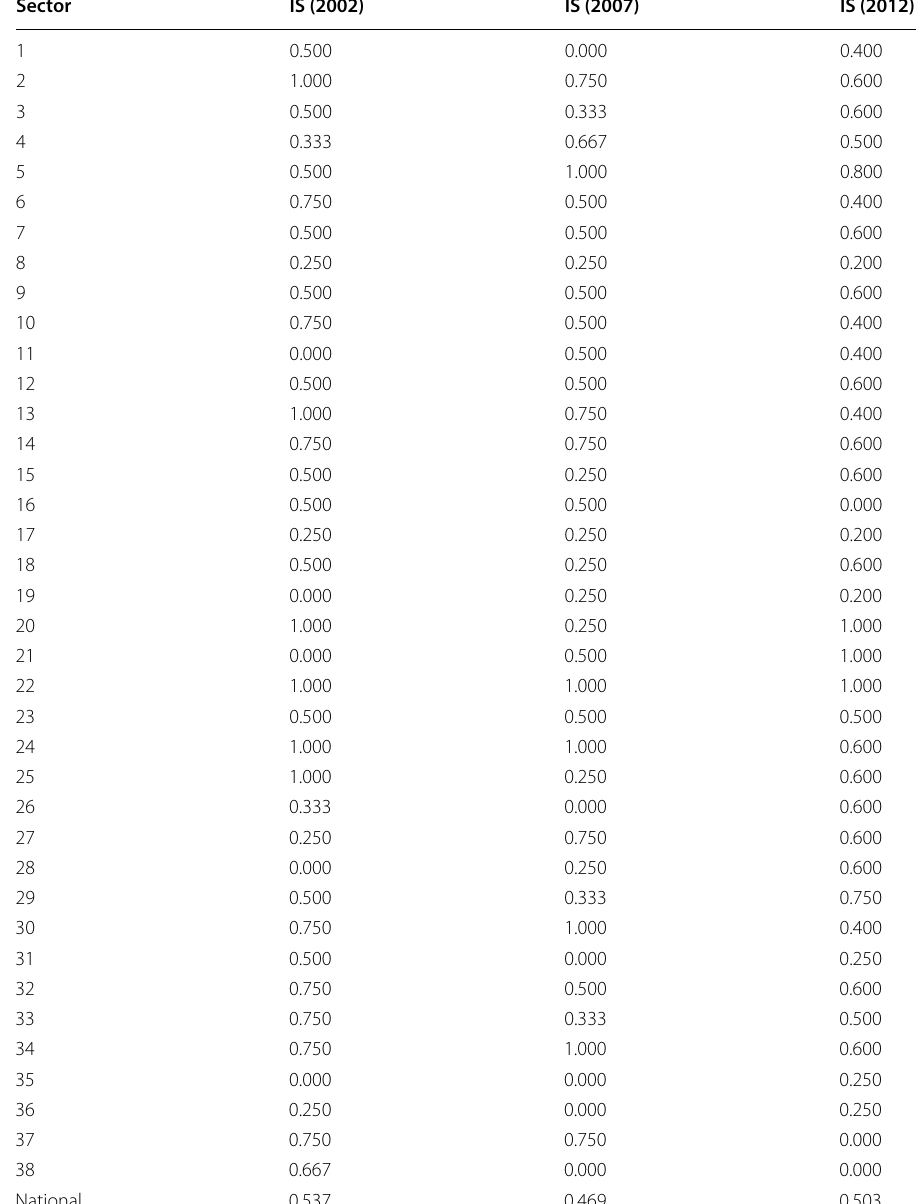
Table 14 IS indicators summed by